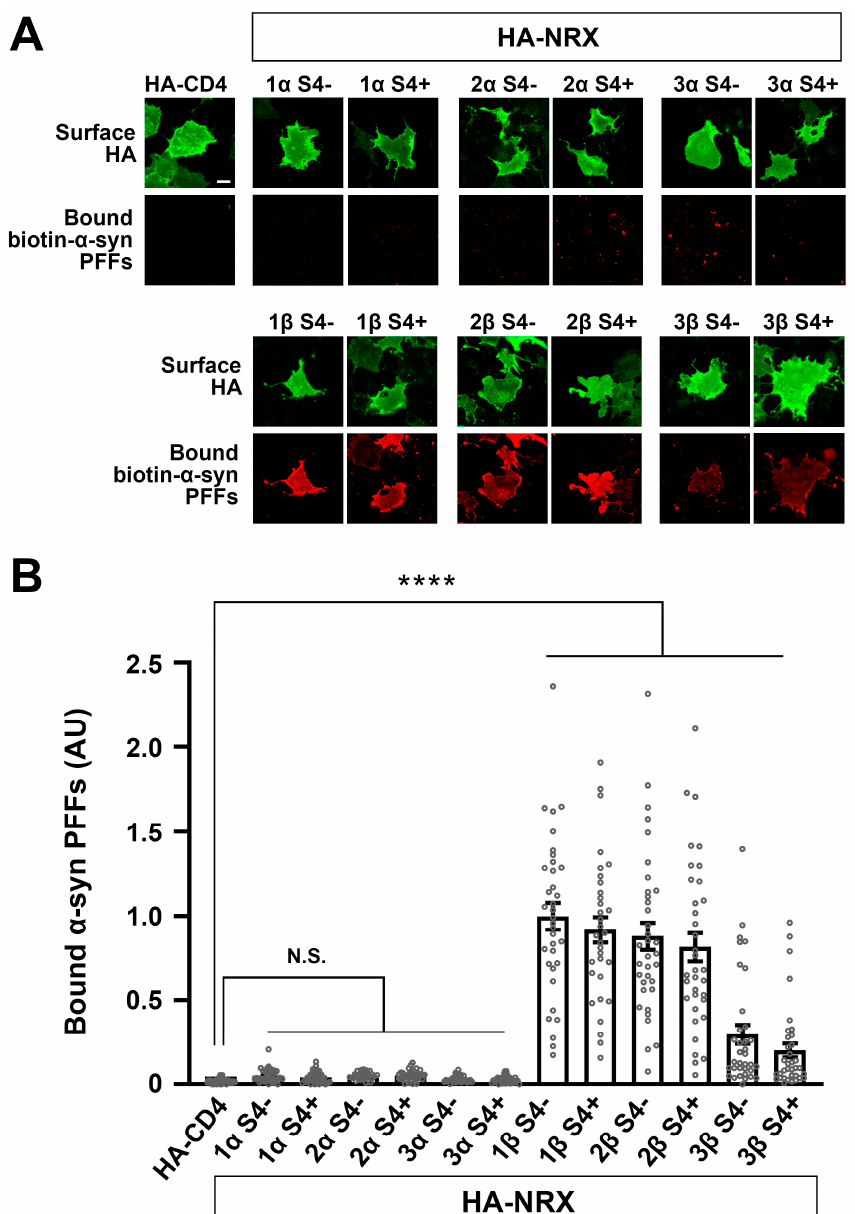
Figure 4. α -syn PFFs selectively bind to β -isoforms, but not α -isoforms, of NRXs. ( A ) Representative images showing the binding of biotin- α -syn PFFs (1 µ M, monomer equivalent) to COS-7 cells expressing the indicated isoform of extracellularly HA-tagged NRX. S4 − and S4+ indicate without and with an insert at splicing site 4, respectively. Surface HA (green) was immunolabelled to verify the expression of these constructs on the COS-7 cell surface. Scale bar: 30 µ m. ( B ) Quantification of the average intensity of bound biotin- α -syn PFFs on COS-7 cells expressing the indicated constructs. Only β -isoforms of NRXs show the significant binding of biotin- α -syn PFFs. α -NRXs have no binding of biotin- α -syn PFFs. Kruskal-Wallis one-way ANOVA, p < 0.0001. **** p < 0.0001 compared with HA- CD4 by Dunn’s multiple comparisons test. N.S., not significant. Data are presented as mean ± SEM. ( n = 30 cells for each of three independent